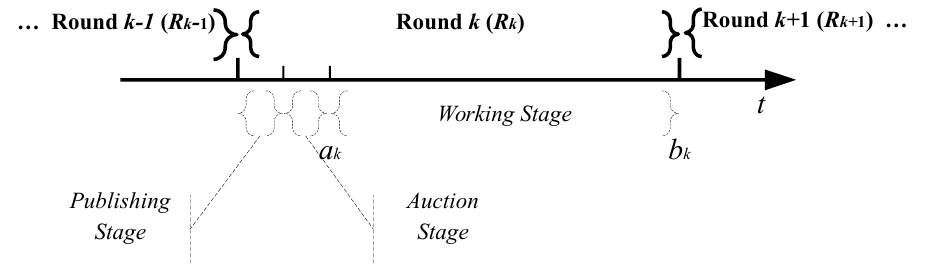
Figure 2. The interactive process between the crowdsourcing platform (CP) and mobile users with devices (MUDs). Table 1. Table of